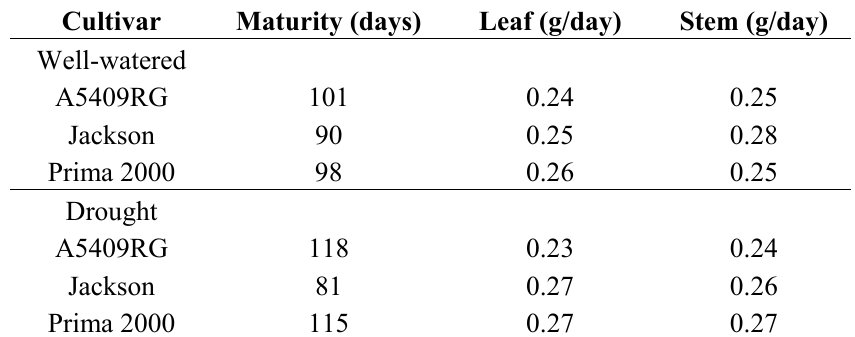
Table 4. A comparison of time to maturity and biomass accumulation in soybean cultivars A5409RG, Jackson and Prima